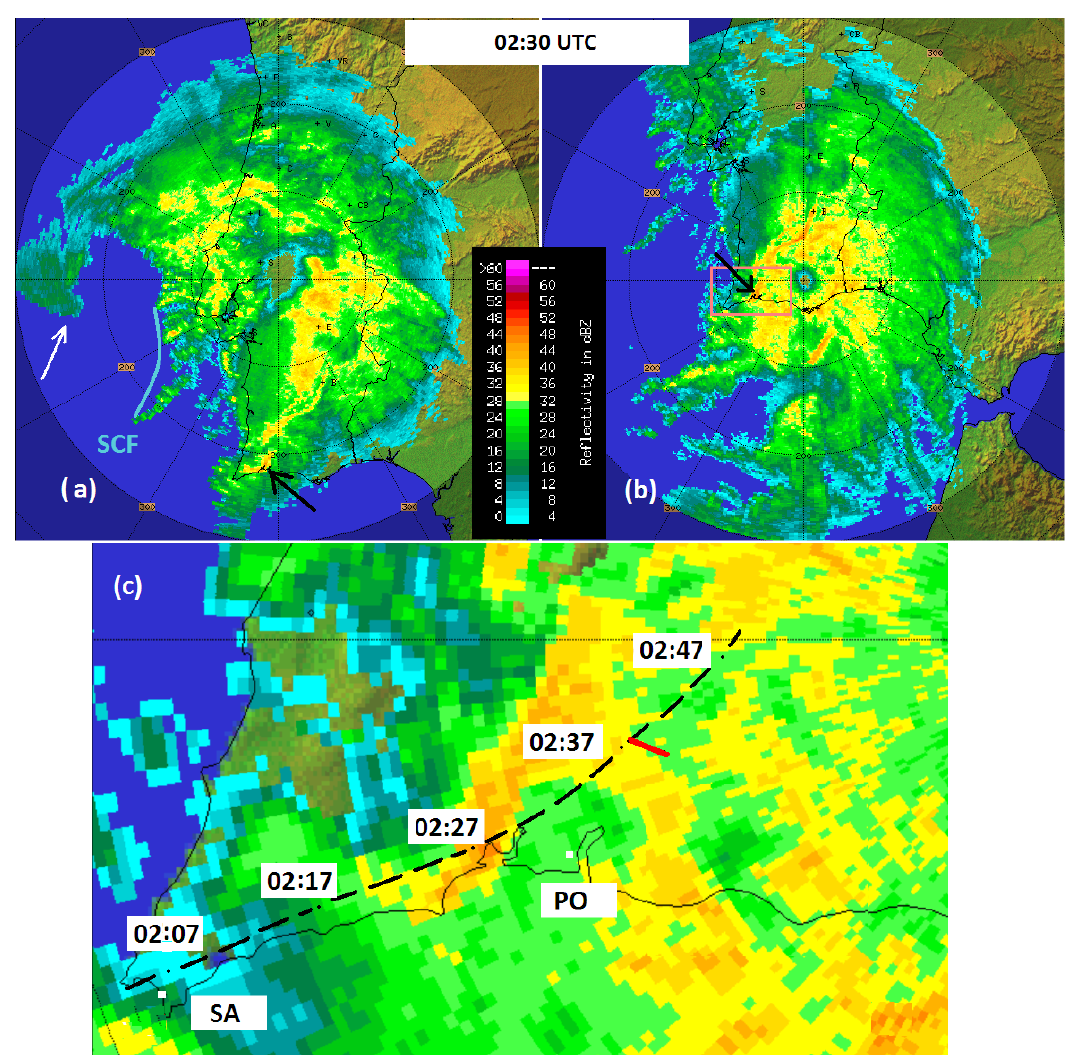
Figure 7. MAXZ at 02:30 UTC on 23 December 2009, from ( a ) CL radar and ( b ) CC radar. Cloud head tip marked by white arrow, SCF by blue line and damaging bow echo by black arrows. ( c ) zoomed-in area from ( b ), trajectory and time of the damaging mesovortex is marked by dashed line. The locations of Sagres (SA) and Portimão (PO) are represented. Area of damage by 02:38 UTC is marked by red line.